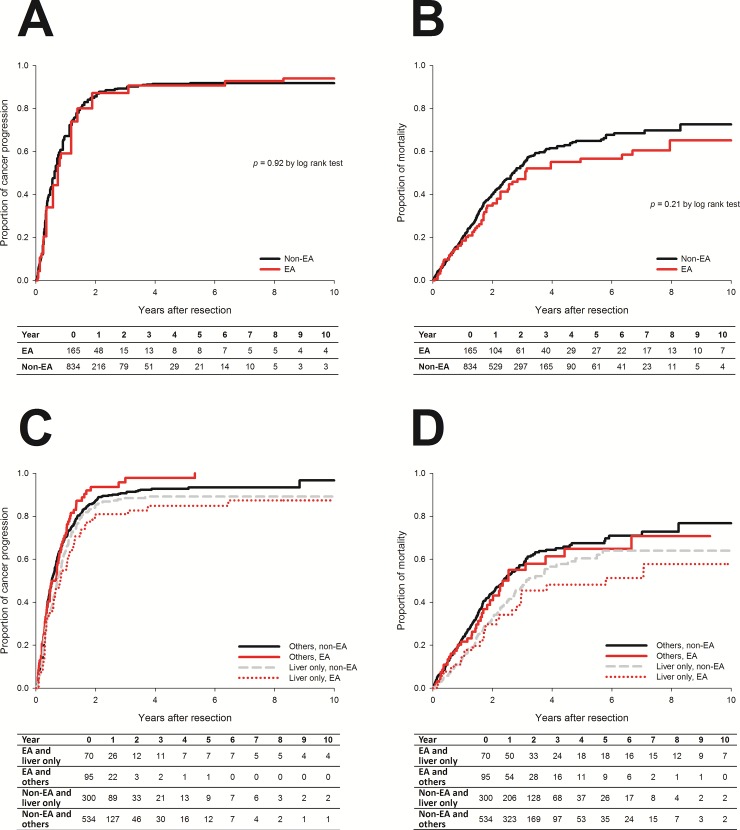
Cumulative incidences of cancer progression and all-cause mortality between EA and non-EA groups.No significant difference in cancer progression (Fig 2A and 2B) or overall mortality (Figs 2C and 2D) after surgery for stage IV colorectal cancer was noted when comparing EA with non-EA groups.